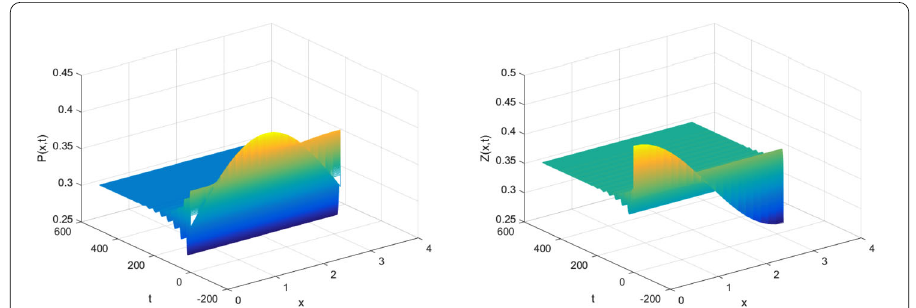
Figure 5 The numerical simulations of system (1.2) with τ = 0.5